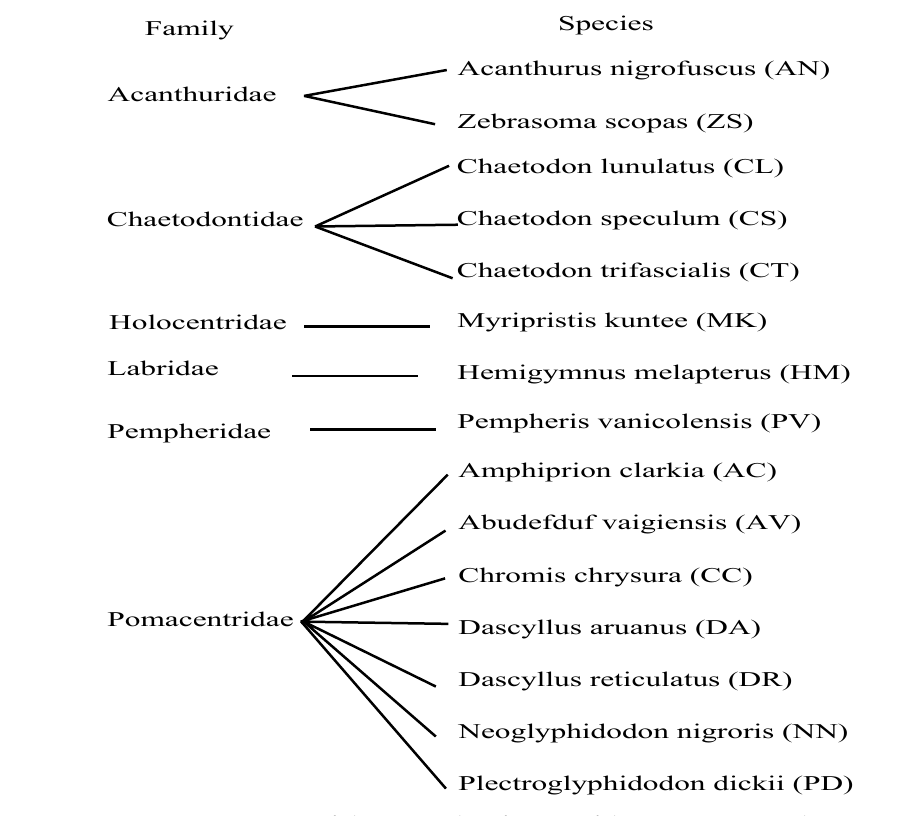
Figure 11. Taxonomic fish species classification of the LCF-15 images dataset. Table 5. Performance of the root node of the hierarchical model for the LCF-15 dataset.